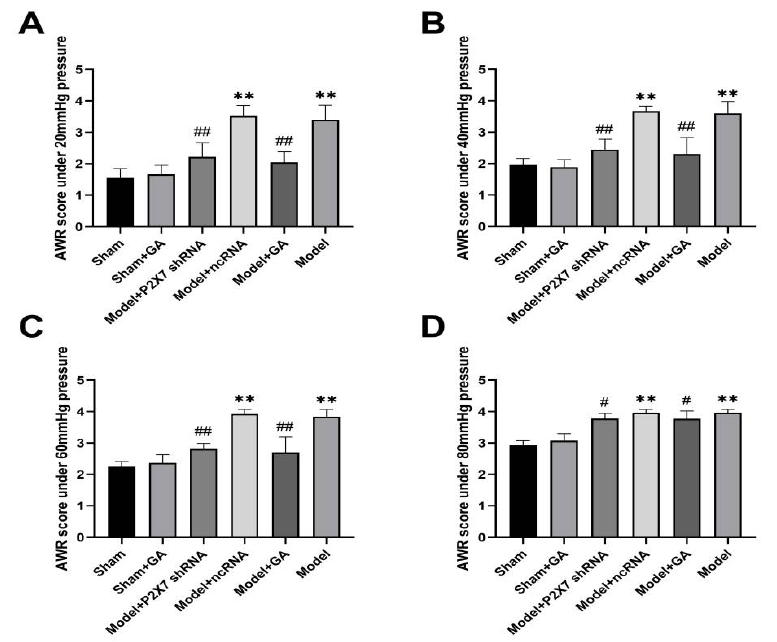
Figure 2. The chronic visceral hypersensitivity in rats was reflected in the AWR score in different groups under 20 mm/Hg (F(5,53) = 51.642, p < 0.001). ( A ) 40 mm/Hg (F(5,53) = 49.327, p < 0.001). ( B ) 60 mm/Hg (F (5,53) = 56.527, p < 0.001). ( C ) and 80 mm/Hg pressure (F(5,53)= 59.456, p < 0.001). ( D ) Values are means ± SEM. p -value was calculated by ANOVA. ** p < 0.01 vs. sham group; # p < 0.05 and ## p < 0.01 vs. model